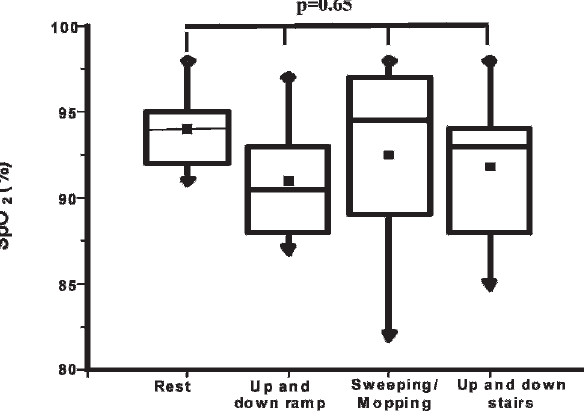
Figure 3 - Boxplot of resting and post-activity (walking up and down ramp, sweeping/mopping and up and down stairs) sensations of dyspnea in COPD patients. Data are presented as medians ¡ maximum/minimum values.